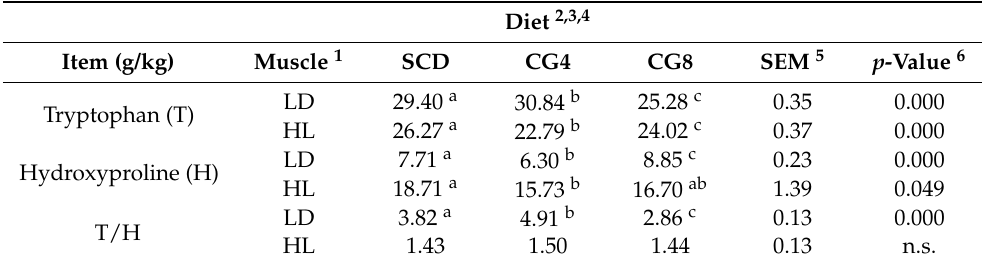
Table 4. Impact of freshwater C. glomerata biomass inclusion in the diet of rabbits on tryptophan and hydroxyproline levels and ratios in different rabbit muscles. Diet 2,3,4 Item (g/kg) Muscle 1